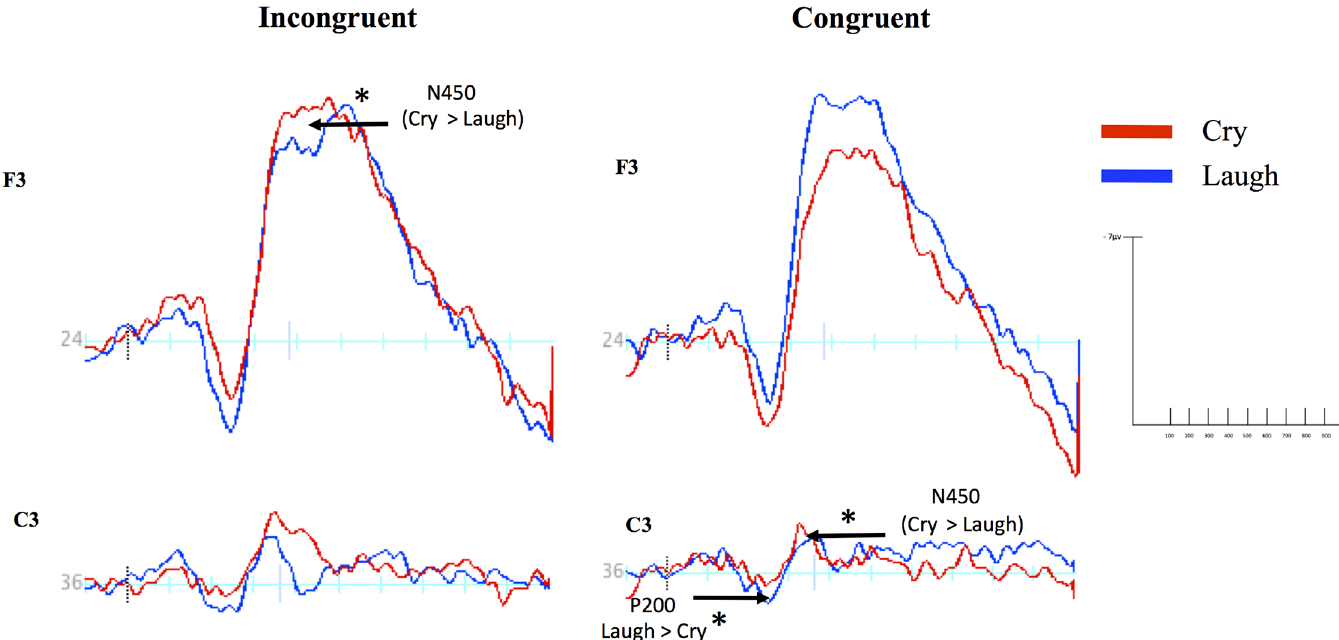
Fig 5. The cry effect on electrocortical responses during incongruent and congruent trials occurred in the frontal and central locations, respectively. Waveforms presented (in microvolts) cry (red lines) and laugh blocks (blue lines) at left frontal (F3) and left central (C3) locations for both incongruent (left column) and congruent trials (right column). Asterisks ( * ) denote statistical differences between cry and laugh ERPs with a significance level at p <